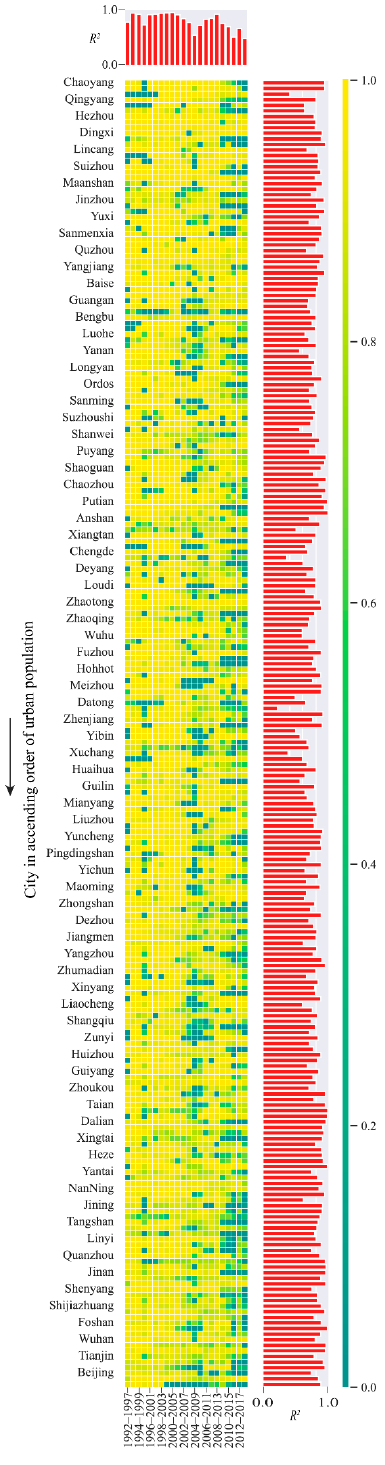
Figure 9. Goodness of fit of the Gaussian model for fitting spatiotemporal variations in intensity of urban-related human activities observed in the 234 sample cities between 1992 and 2018, with lower limit of DN values set to 30 and interval of time set to 5 years. (The x -axis of the central plot indicates the 234 cities in ascending order of their urban population from left to right, and the y -axis indicates the years (1992–2018) from top to bottom in an ascending order. The subplot at the top indicates the average R 2 of the fitted Gaussian model of each city, and the subplot on the right indicates the aver- age R 2 of each time interval.)